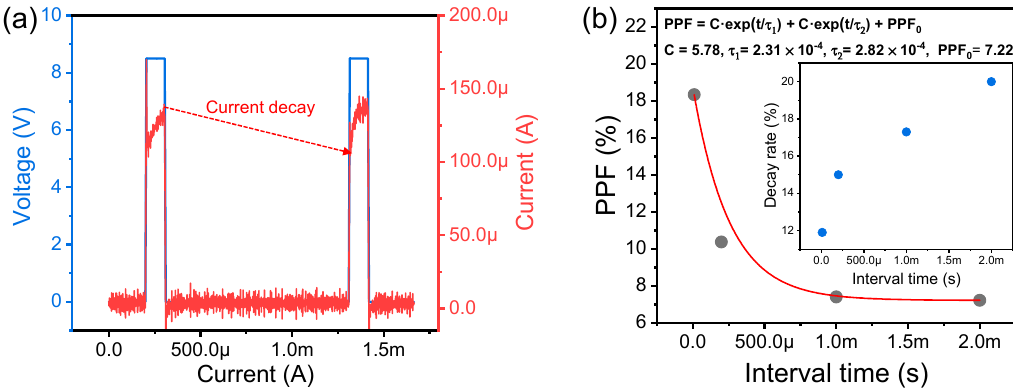
Figure 6. PPF characteristics of the Cu / AlN / TiN device: ( a ) Transient characteristics given two identical pulse inputs; ( b ) PPF and decay rate as a function of interval time.